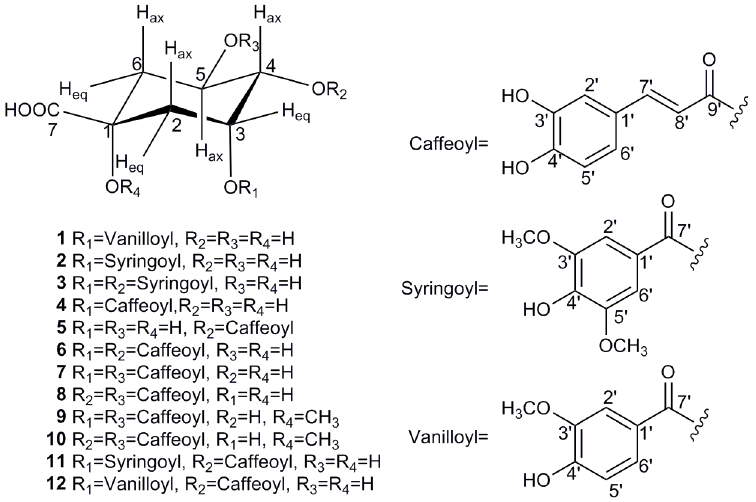
Figure 2. Chemical structures of compounds 1 – 12 isolated from C. spinarum .